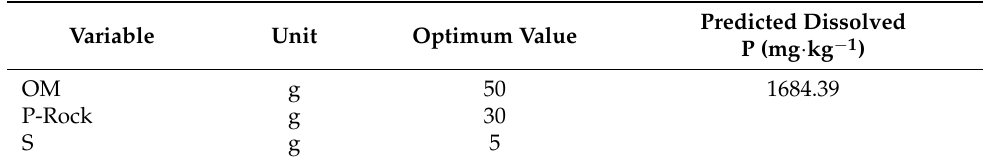
Table 4. Optimized values of the model input parameters to obtain the maximum predicted dissolved P